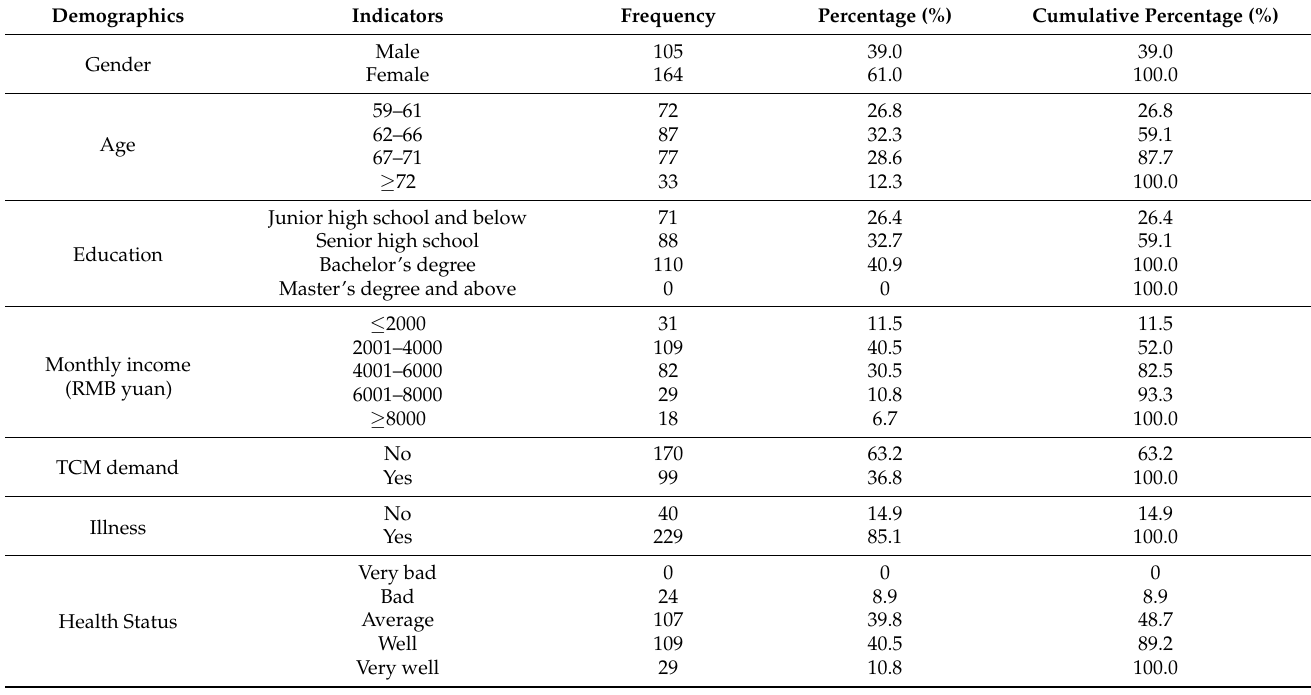
Table 3. Demographic Characteristics of the sample (N =